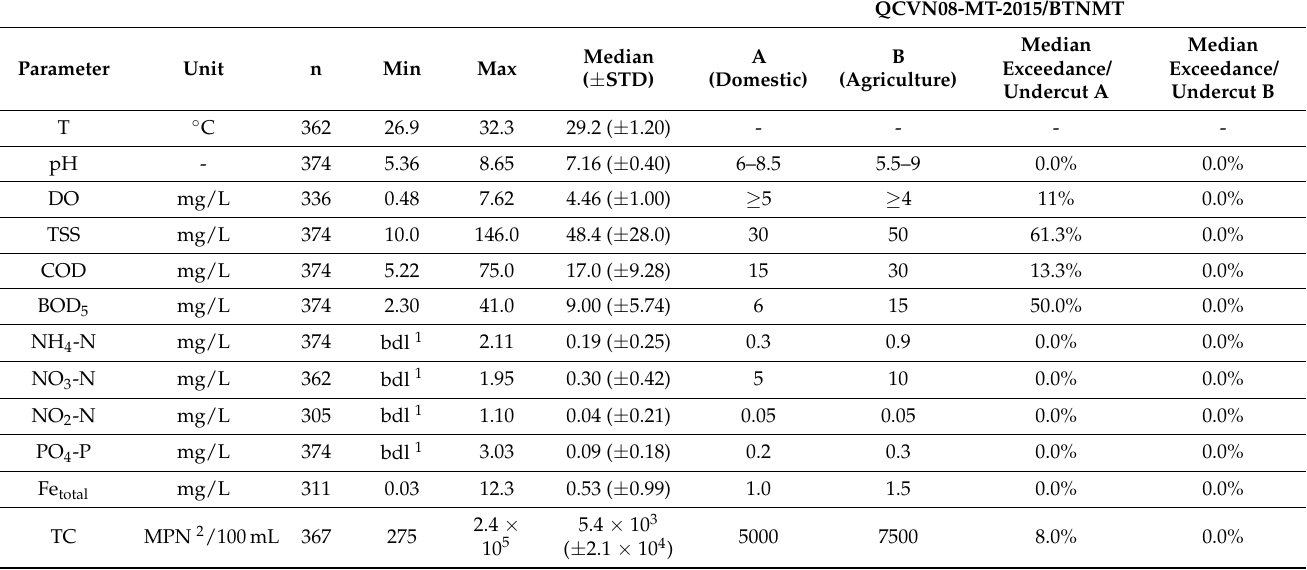
Table 2. General water quality of freshwater samples of investigated monitoring stations with minimum, maximum, and median values as well as the exceedance or undercutting intensity of limit values according to the Vietnamese regulation on surface water quality (QCVN08-MT-2015/BTNMT).